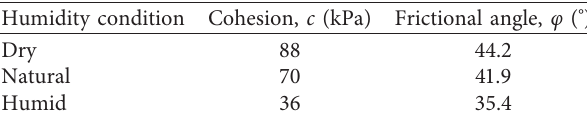
Figure 7: Data of the in situ direct shear tests under natural condition. (a) Shear stress versus shear displacement. (b) Vertical displacement versus shear displacement. Table 3: Strength parameters obtained from the in situ